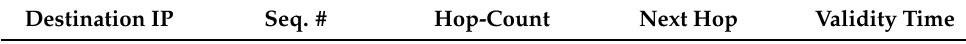
Table 4. Routing Table for ClassB (Reactive).